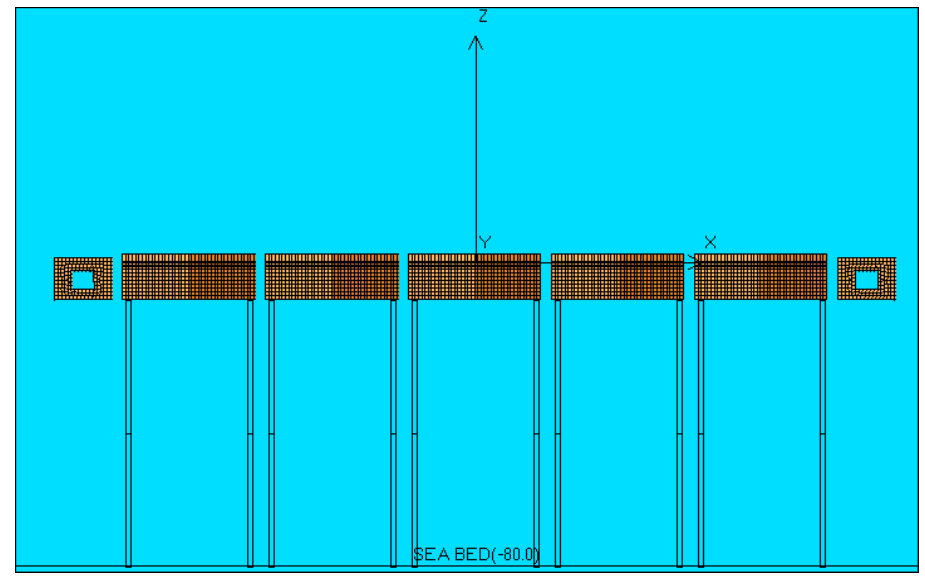
Figure 3. Hydrodynamic model of the MFS system.